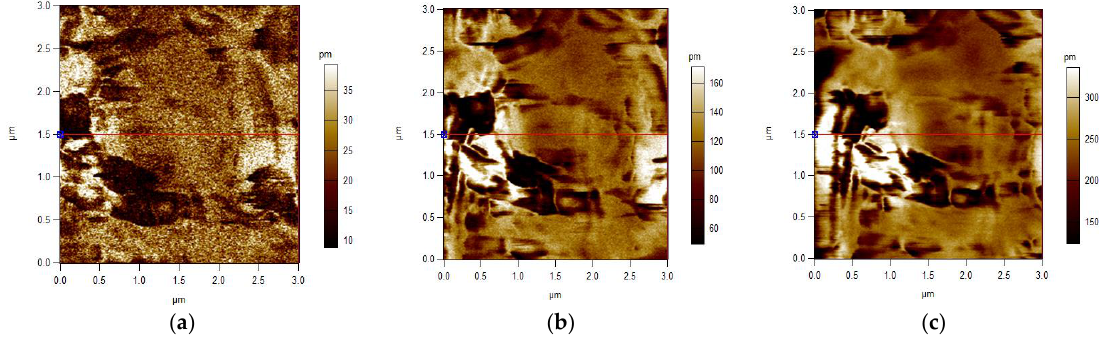
Figure 6. Atomic force microscopy (AFM) surface morphologies at different applied voltages ( a ) 1 V, ( b ) 5 V, and ( c ) 10 V.